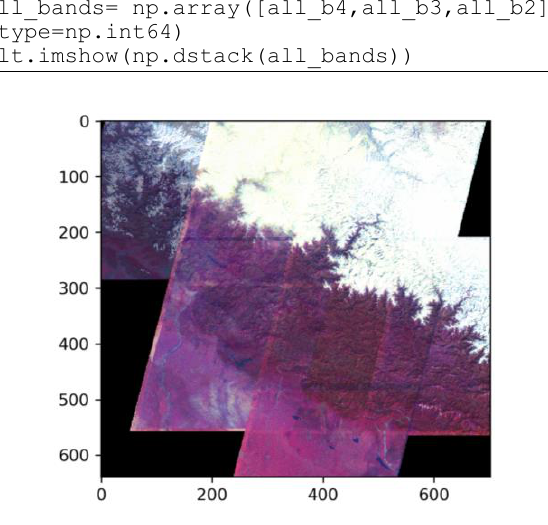
Figure 11. FCC generation of